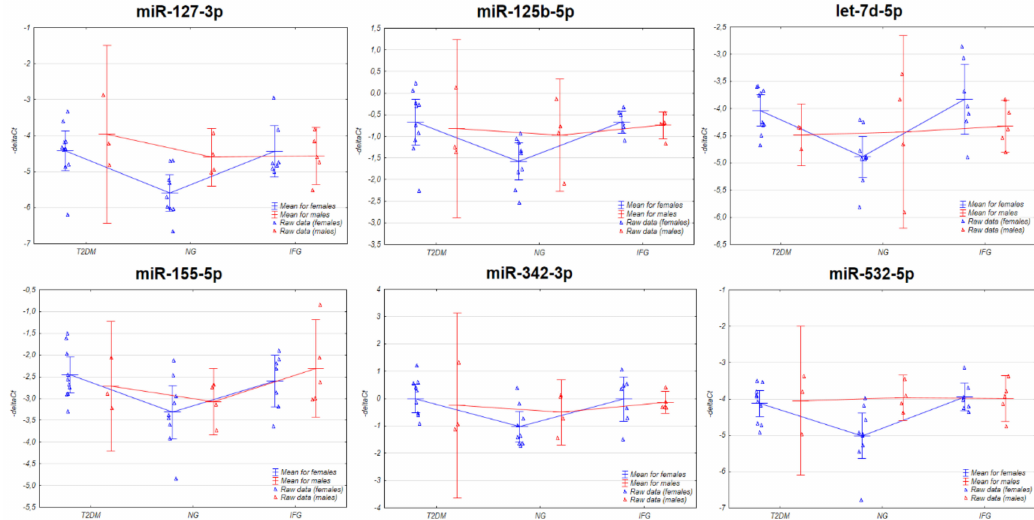
Figure A3. Plots for miR-127-3p, miR-125b-5p, let-7d-5p, miR-155-5p, miR-342-3p and miR-532-3p showing mean -deltaCt values with regard to studied group and sex for all study subjects (N = 38).